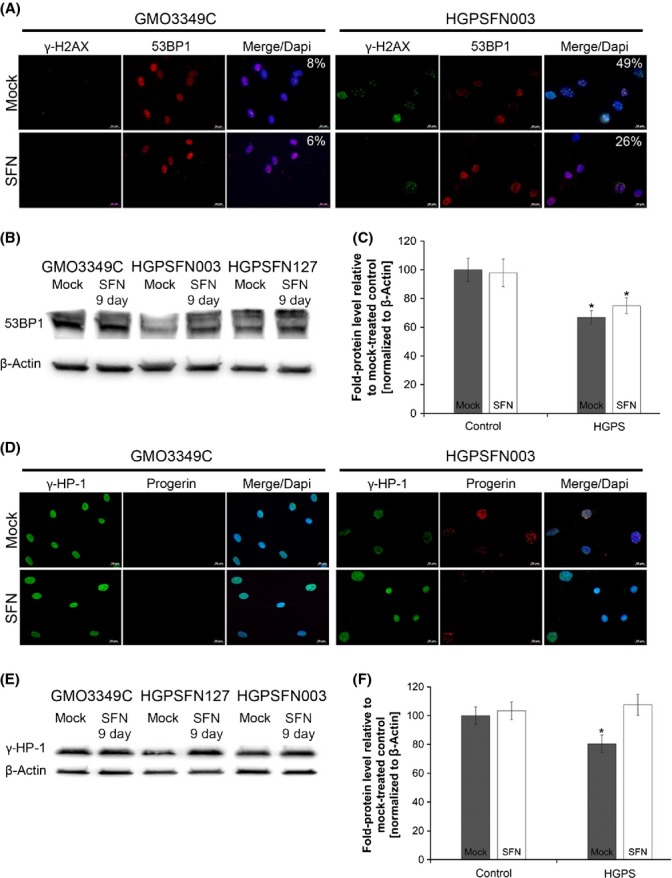
Sulforaphane (SFN) ameliorates the levels of DNA damage in Hutchinson–Gilford progeria syndrome (HGPS) cells. (A) Immunocytochemistry using antibodies directed against indicated proteins (γ-H2AX and 53BP1) was performed on normal (GMO3349C) and HGPS (HGADFN003) cells mock-treated or SFN-treated cells for 9 days. The percentage of nuclei showing γ-H2AX foci is indicated (n = 4). Scale bar: 20 μm. (B) Western blot evaluation of 53BP1 levels in control and HGPS cells that were treated as in (A). (C) Quantification of 53BP1 levels normalized to β-actin and presented as the fold change relative to control cells (*P < 0.05; n = 3). (D) Immunocytochemistry using antibodies directed against indicated proteins (HP1-γ and progerin) was performed on normal (GMO3349C) and HGPS (HGADFN003) cells mock-treated or SFN-treated for 9 days. (E) Western blot evaluation of HP1-γ levels in control and HGPS cells that were treated as in (D). (F) Quantification of HP1-γ levels normalized to β-actin and presented as the fold change relative to control cells (*P < 0.05; n = 3).